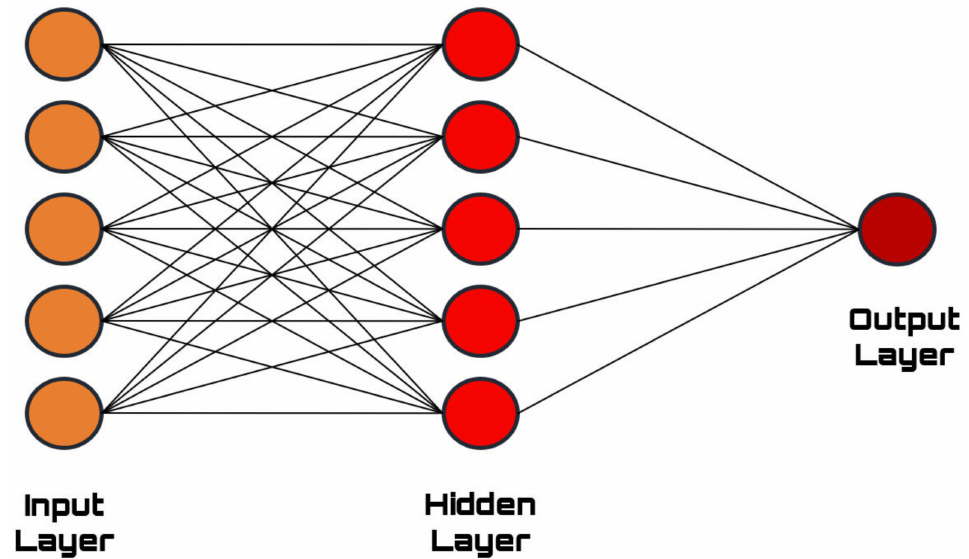
Figure 4. Typical ANN architecture: we can identify an input layer that presents the data to the structure, a hidden layer that takes care of processing data, and, finally, an output layer that returns the